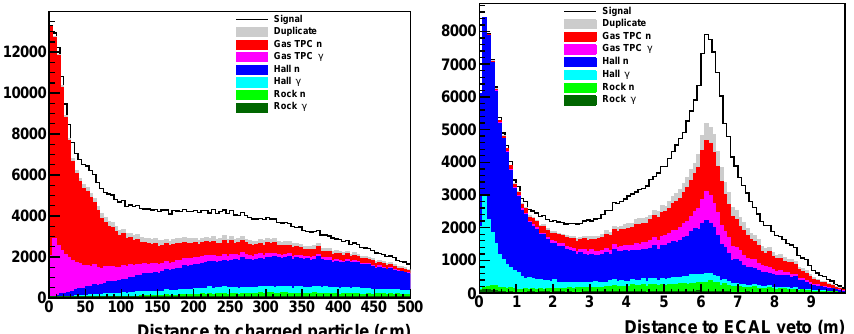
Figure 80. Number of hit cells in the ECAL cluster as a function of the maximum hit energy in the cluster for true photons ( left ) and true neutrons ( right ). Neutron clusters are selected to the right of the green line N cells = 5MeV −1 (Max cell [MeV]-4).